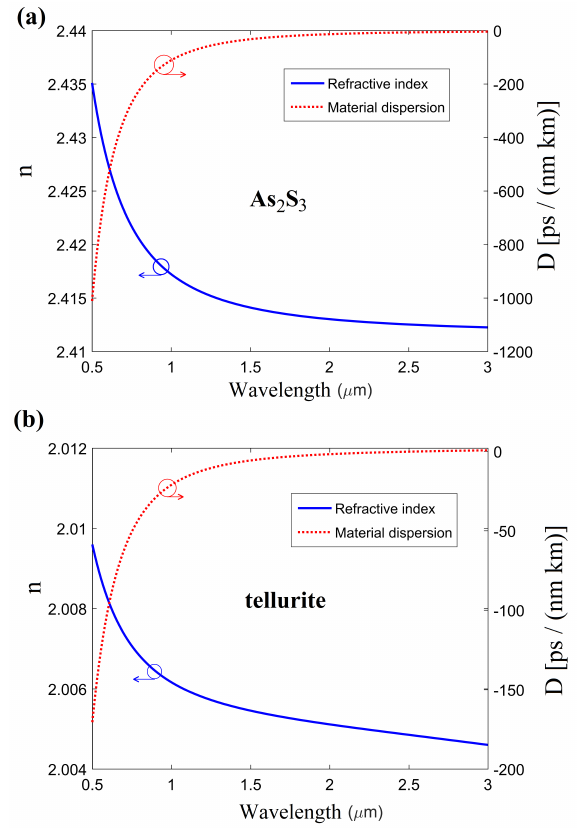
Figure 1. Linear refractive index and material dispersion of ( a ) As 2 S 3 and ( b ) tellurite glass as a function of wavelength. The solid blue curve and left vertical axis represent refractive index values, and dotted red curve and right vertical axis represent material